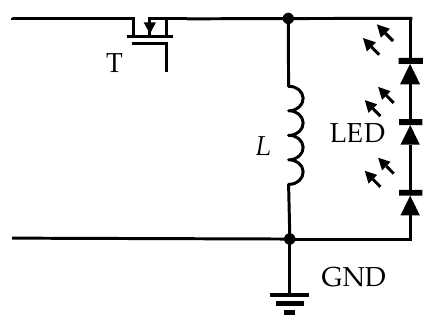
Figure 9. Simplified LED buck–boost converter.